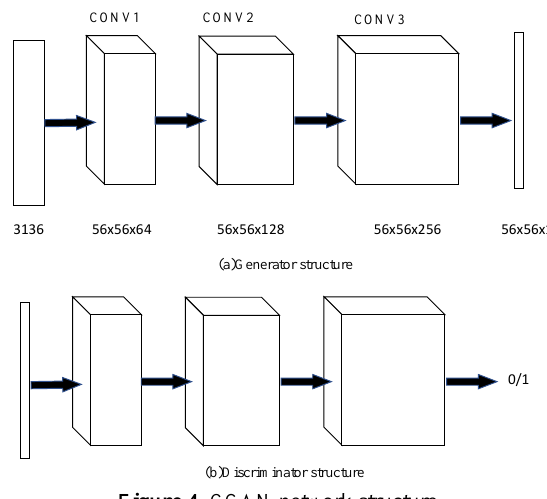
Figure 4 . CGAN network structure.